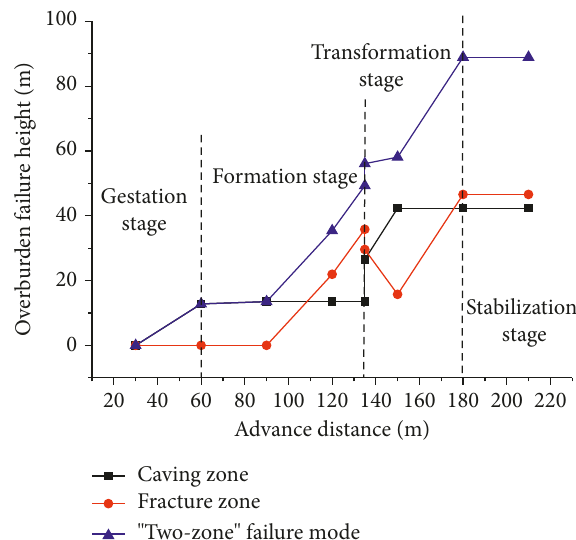
Figure 4: The evolution process of the two-zone failure mode with working face moving.